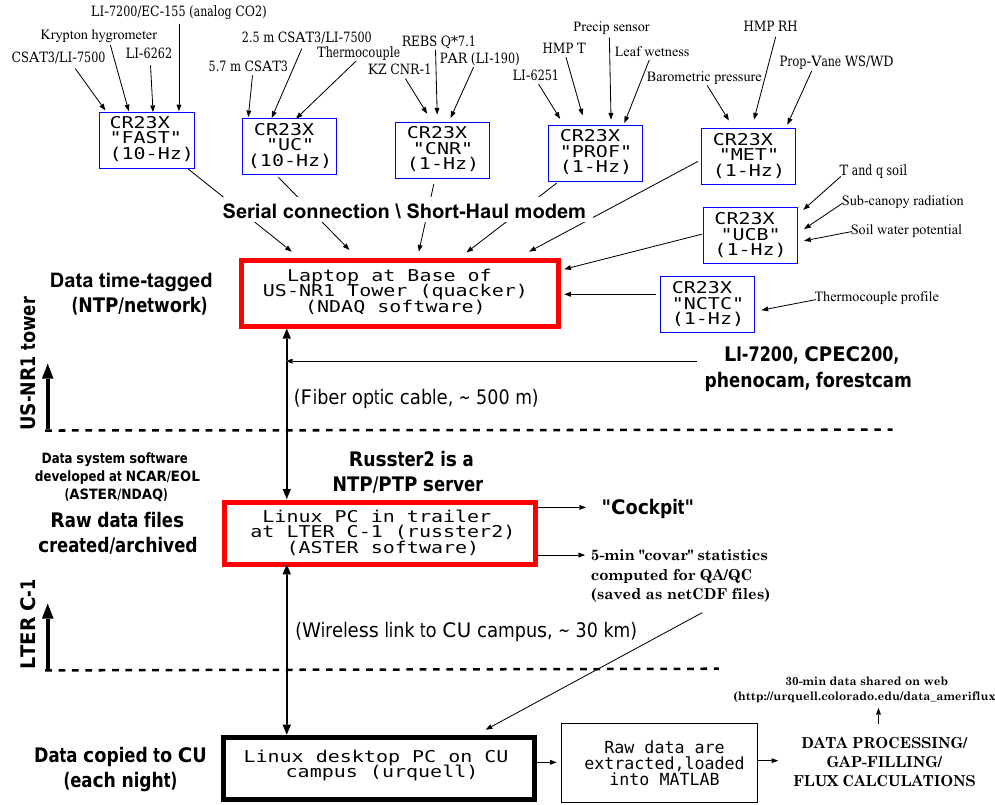
Figure 1. Schematic flow chart of data collection with the ASTER/NDAQ data acquisition software that was used between June 2004 and October 2014 at the Niwot Ridge US-NR1 AmeriFlux site. The data flow is from the instruments (at the top of the chart), to the CR23X data loggers, to a laptop (quacker) at the tower for time-tagging, to a desktop computer (russter2) in the trailer at LTER C-1 for archiving, followed by nightly copying of the raw data files to the server on CU campus (urquell). The horizontal dashed lines represent spatial separation of hardware locations; distances are noted in the schematic (the upper portion of the schematic is at the US-NR1 tower, the middle portion at LTER C-1, and the lower portion on the CU campus). The red boxes indicate high-rate data system components that are discussed within the text (Sect.